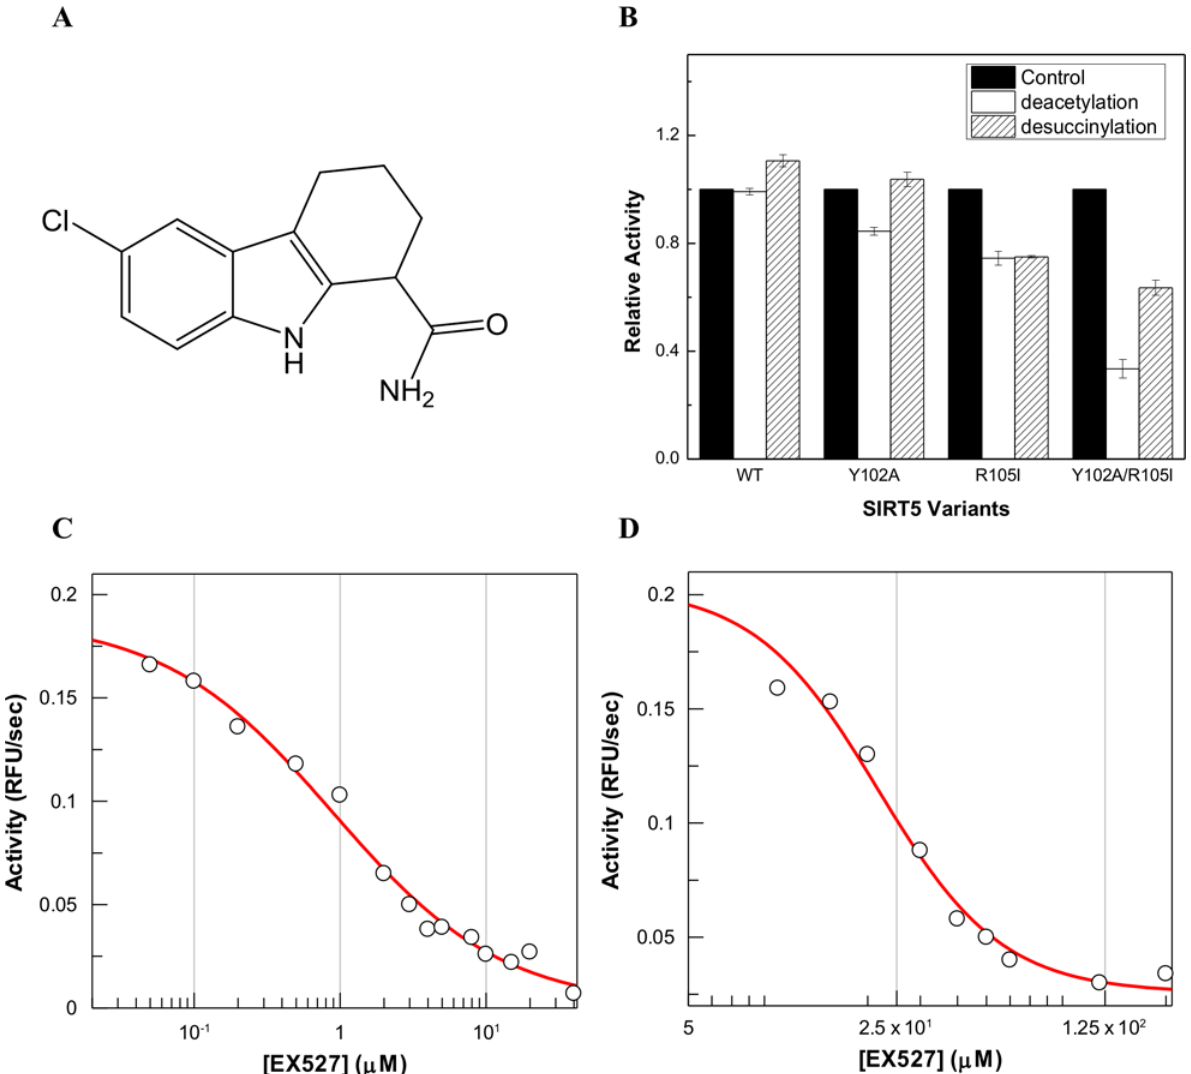
Fig 9. Structure of EX527 and its Effects on SIRT5 Variant Catalyzed Reactions. (A) Structure of EX527. (B) Relative activities of SIRT5 variants in the absence and presence of 50 μ M EX527. (C) Dose-response of SIRT1 deacetylase activity in the presence of increasing concentration of EX527 (from 0 to 40 μ M). (D) Dose-response of SIRT5 Y102A/R105I deacetylase activity in the presence of increasing concentration of EX527 (from 0 to 200 μ M). For (C) and (D), the solid smooth lines represent the best fit of the data for the IC 50 of EX527 against SIRT1 and SIRT5 Y102A/R105I as being equal to 0.9 ± 0.2 μ M and 21.7 ± 1.0 μ M,